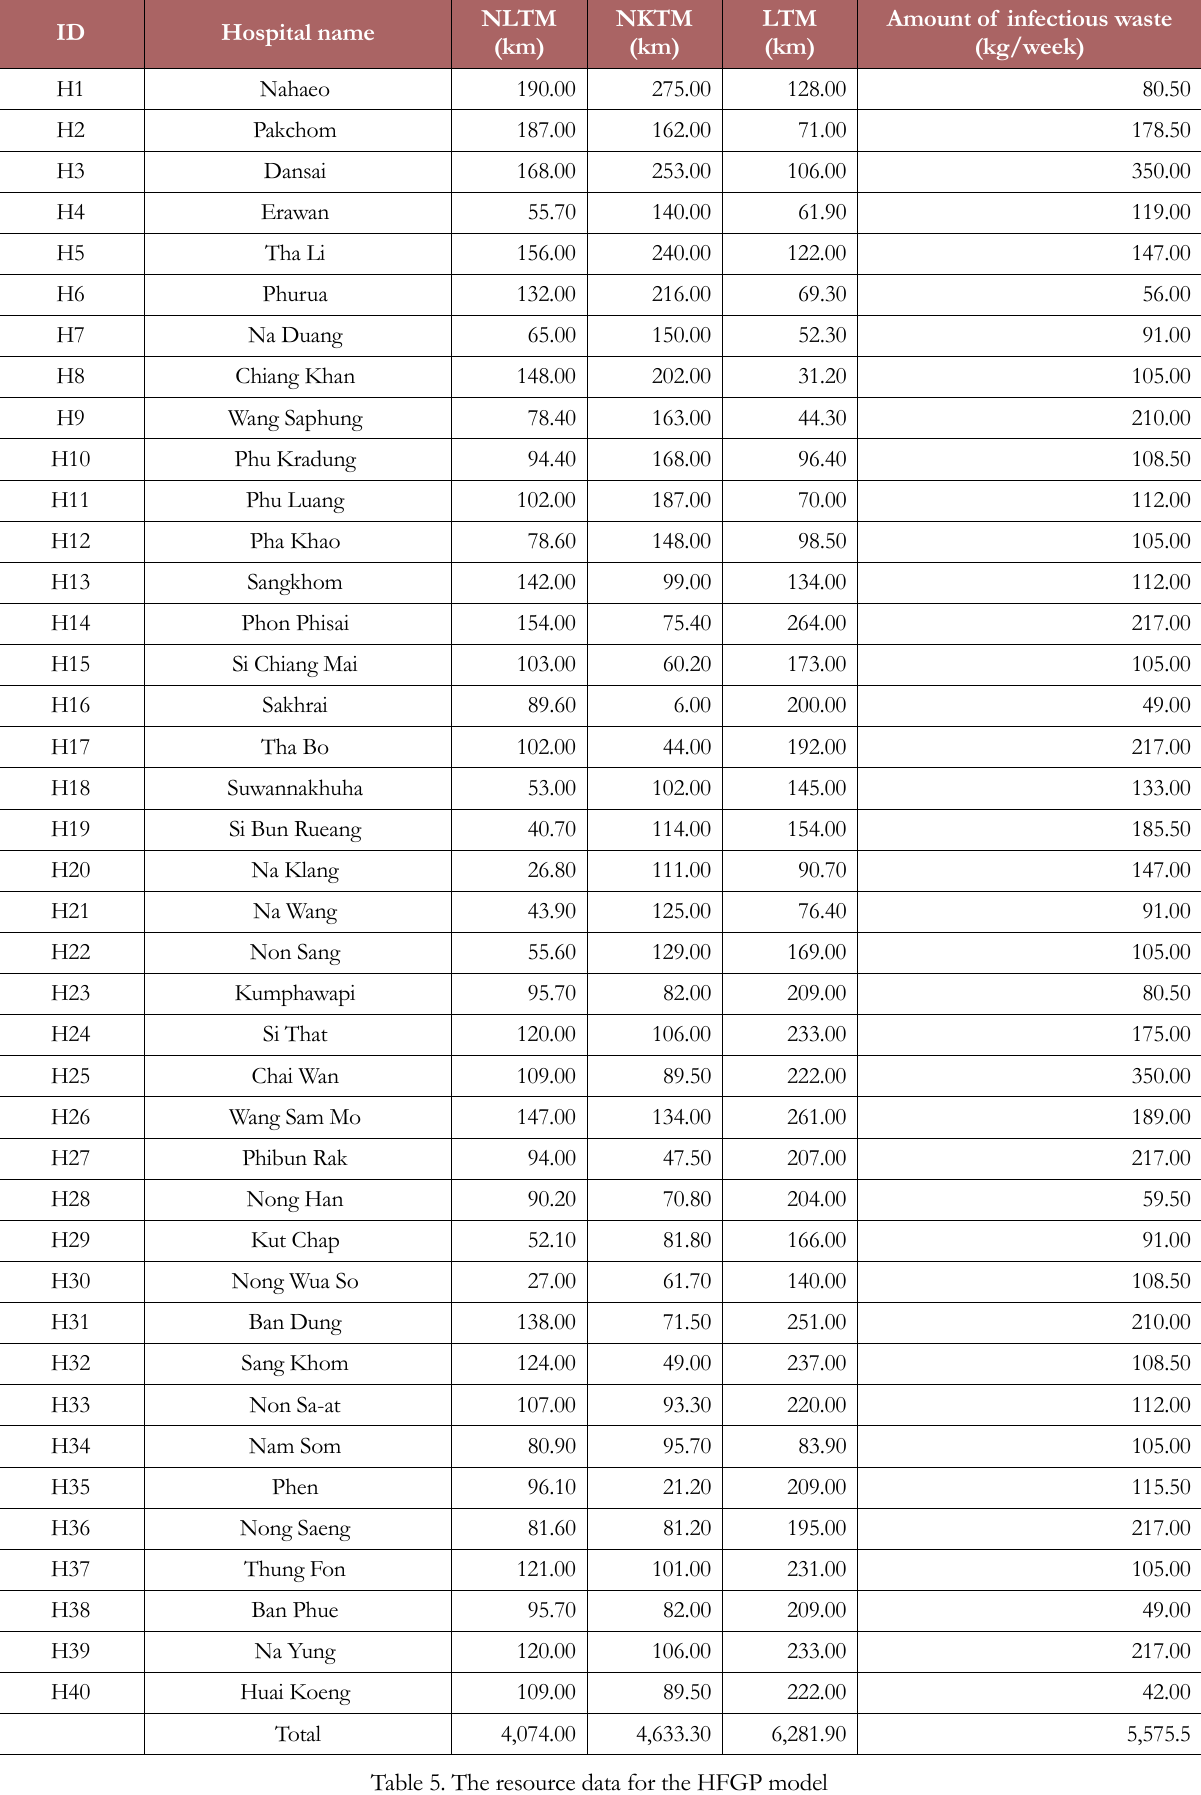
Table 5. The resource data for the HFGP